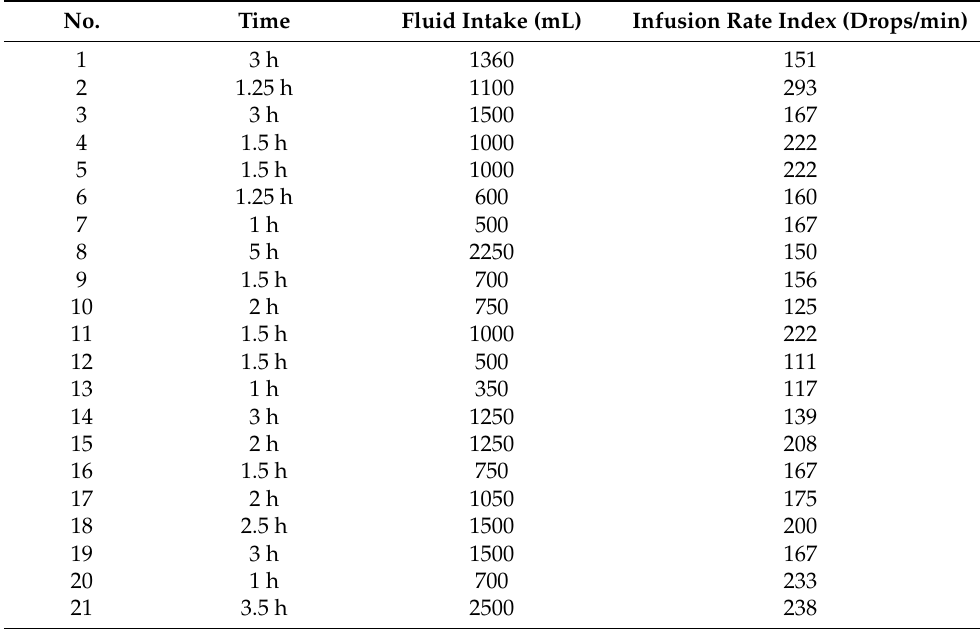
Table 5. IV fluid volumes and rates in the 21 cases of rapid